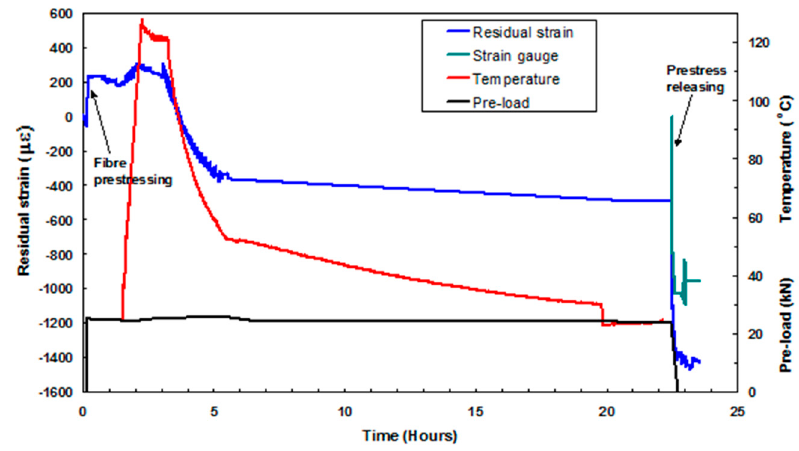
Figure 18. Strain development throughout the processing of a 16-ply UD prepreg system that was subjected to a pre-stress of 150 MPa.